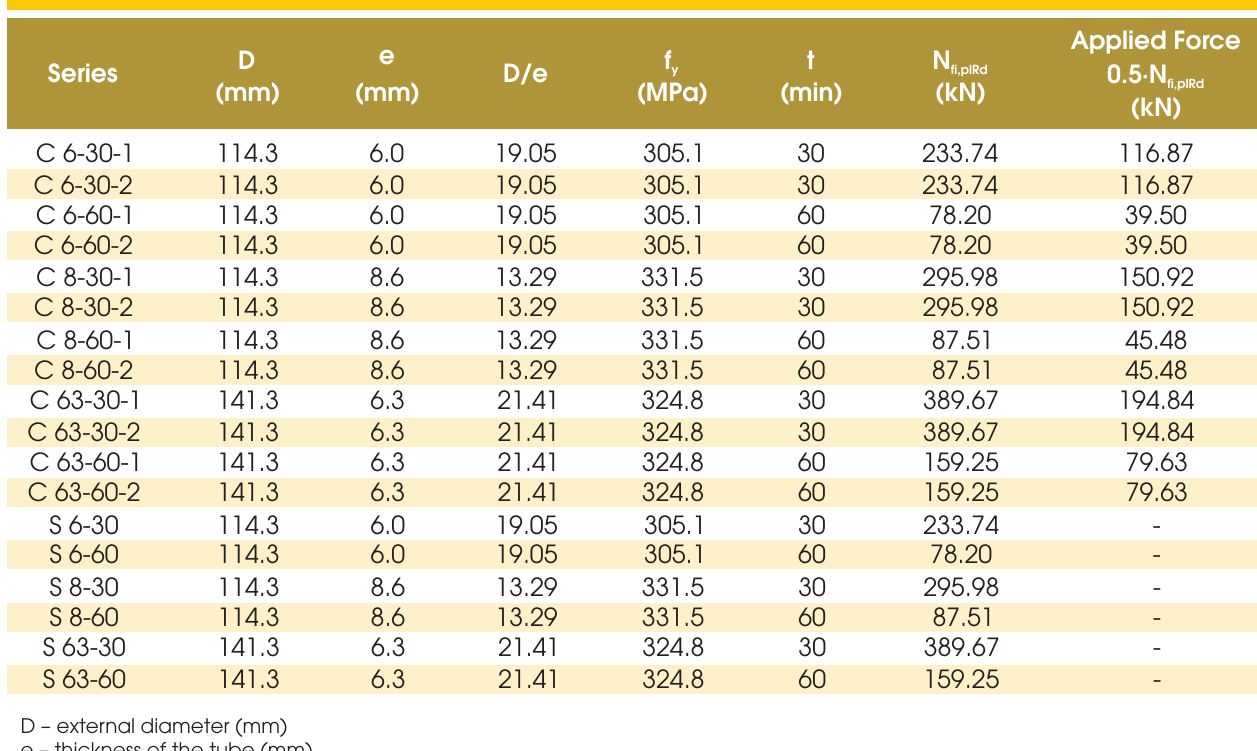
Table 1 – Characteristics of the models tested and the load applied during the